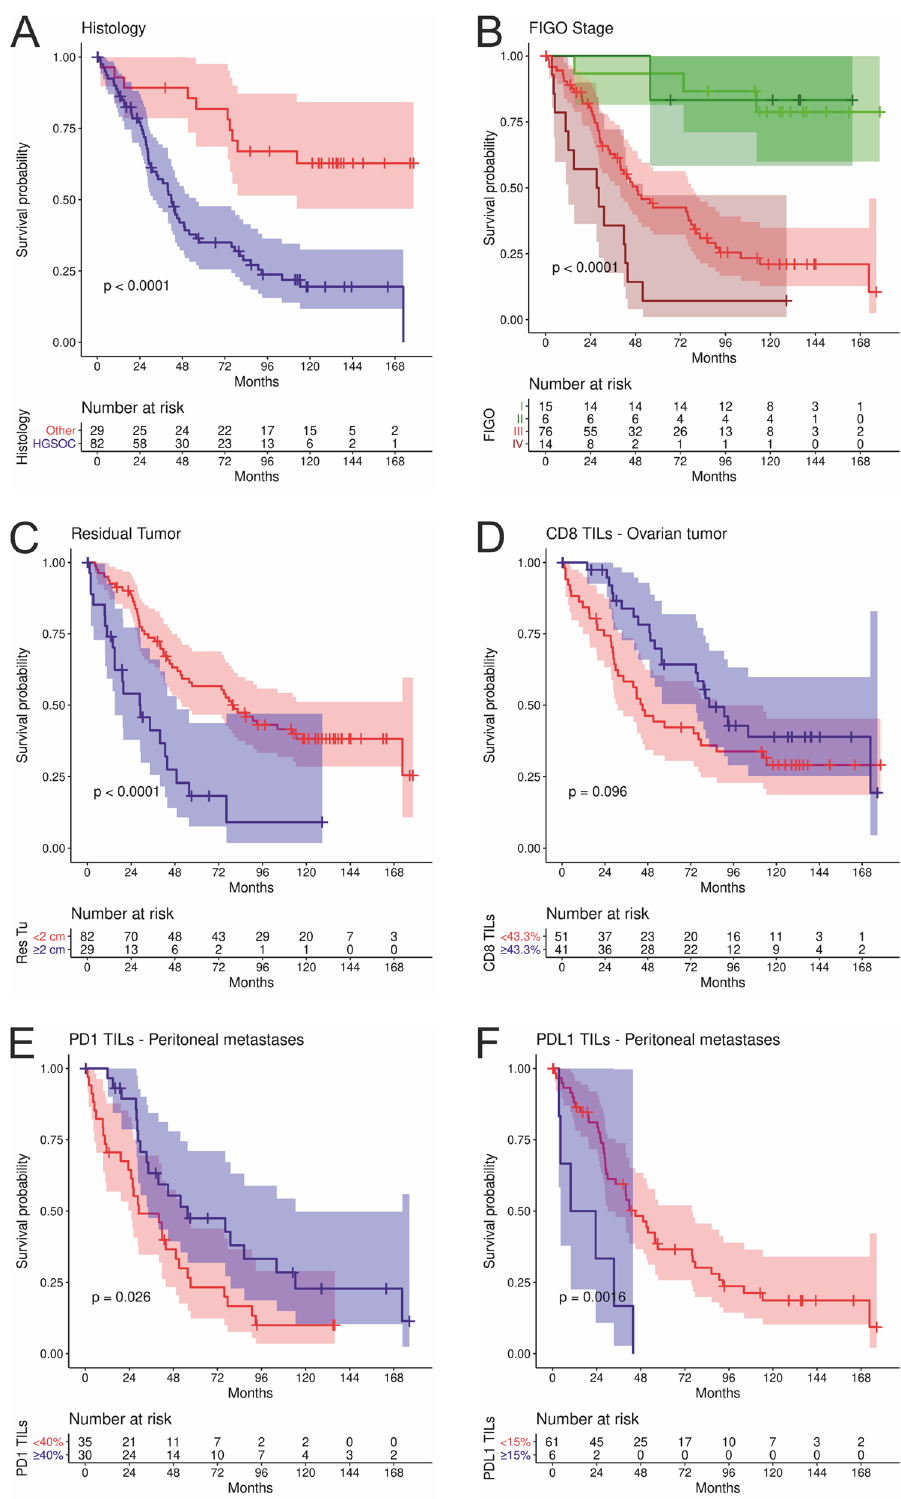
Figure 3. Kaplan–Meier estimates for the clinicopathologic parameters histology ( A ), FIGO stage ( B ), and residual tumor mass after debulking surgery ( C ) and optimally dichotomized CD8 positive TILs in ovarian tumors ( D ), optimally dichotomized PD1 positive TILs ( E ) and optimally dichotomized PDL1 positive TILs in peritoneal metastases ( F ). P-values according to Log-Rank